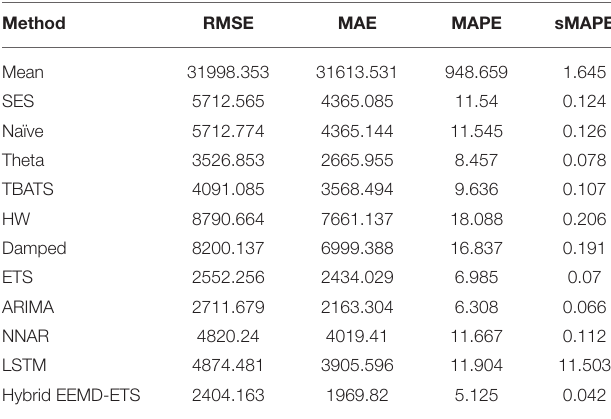
TABLE 5 | Performance of different models for 7 days prediction of Italy’s daily confirmed cases.